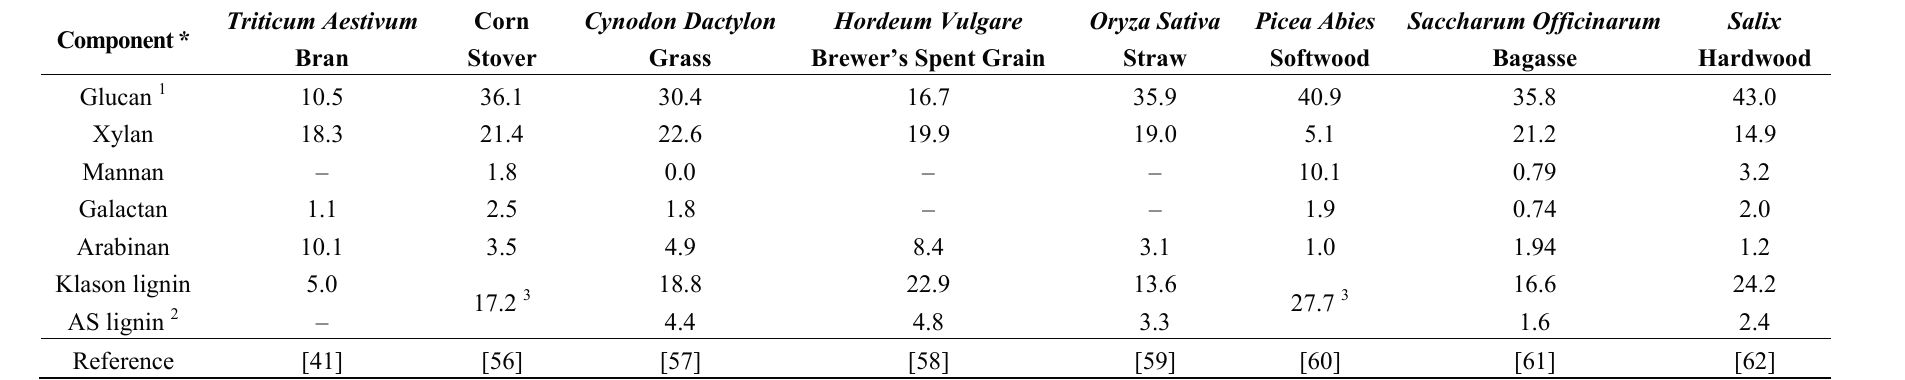
Table 2. Exemplary composition of different lignocellulosic